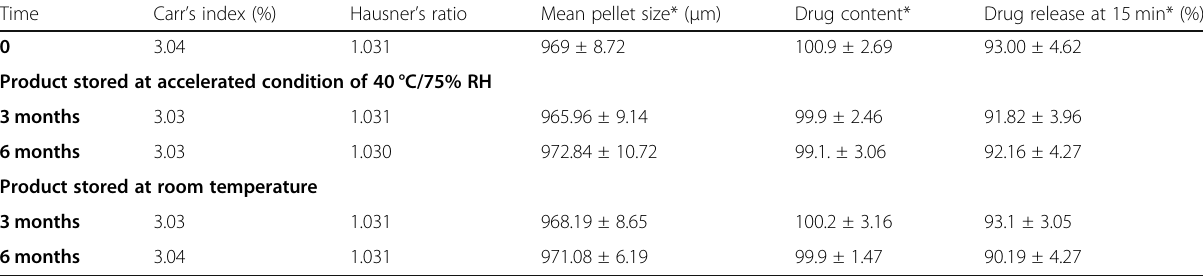
Table 5 Results of stability study of the optimized gliclazide SMEDDS pellets